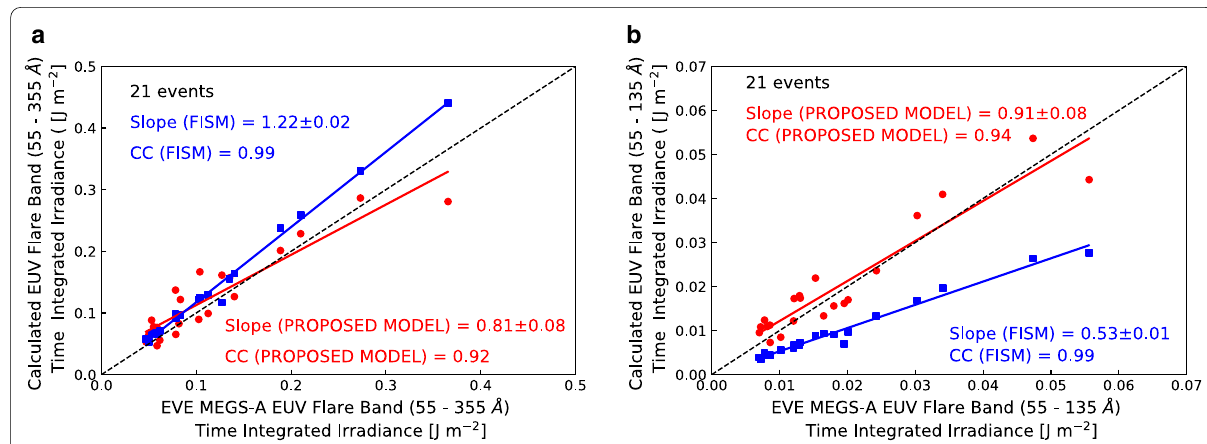
Fig. 11 Comparison results of EUV flare band time-integrated irradiance. The relationship between the SDO/EVE MEGS-A observations and proposed model estimations of the EUV flare energies of two wavelength bands for a 55–355 Å and b 55–135 Å. The results of the proposed model are plotted in red, and the FISM results are plotted in blue. In each panel, the solid line indicates the regression of each plot; the dashed line indicates the straight line with slope of “1” and the slope of regression is shown at the upper left and bottom right